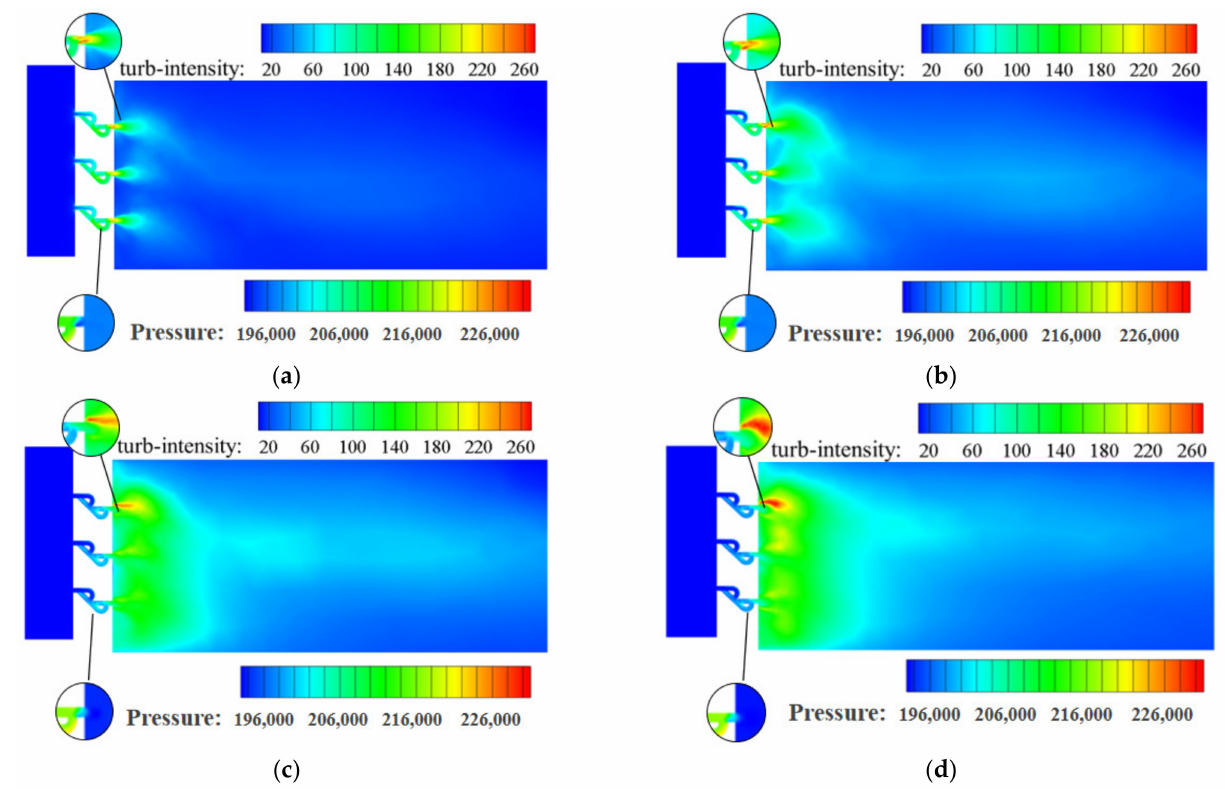
Figure 12. Turbulence intensity distribution on the symmetry plane for the Tesla-type orifice structure under different mass flow rates (%). ( a ) Q m = 0.02 kg s − 1 . ( b ) Q m = 0.1 kg s − 1 . ( c ) Q m = 0.5 kg s − 1 . ( d ) Q m = 1 kg s − 1